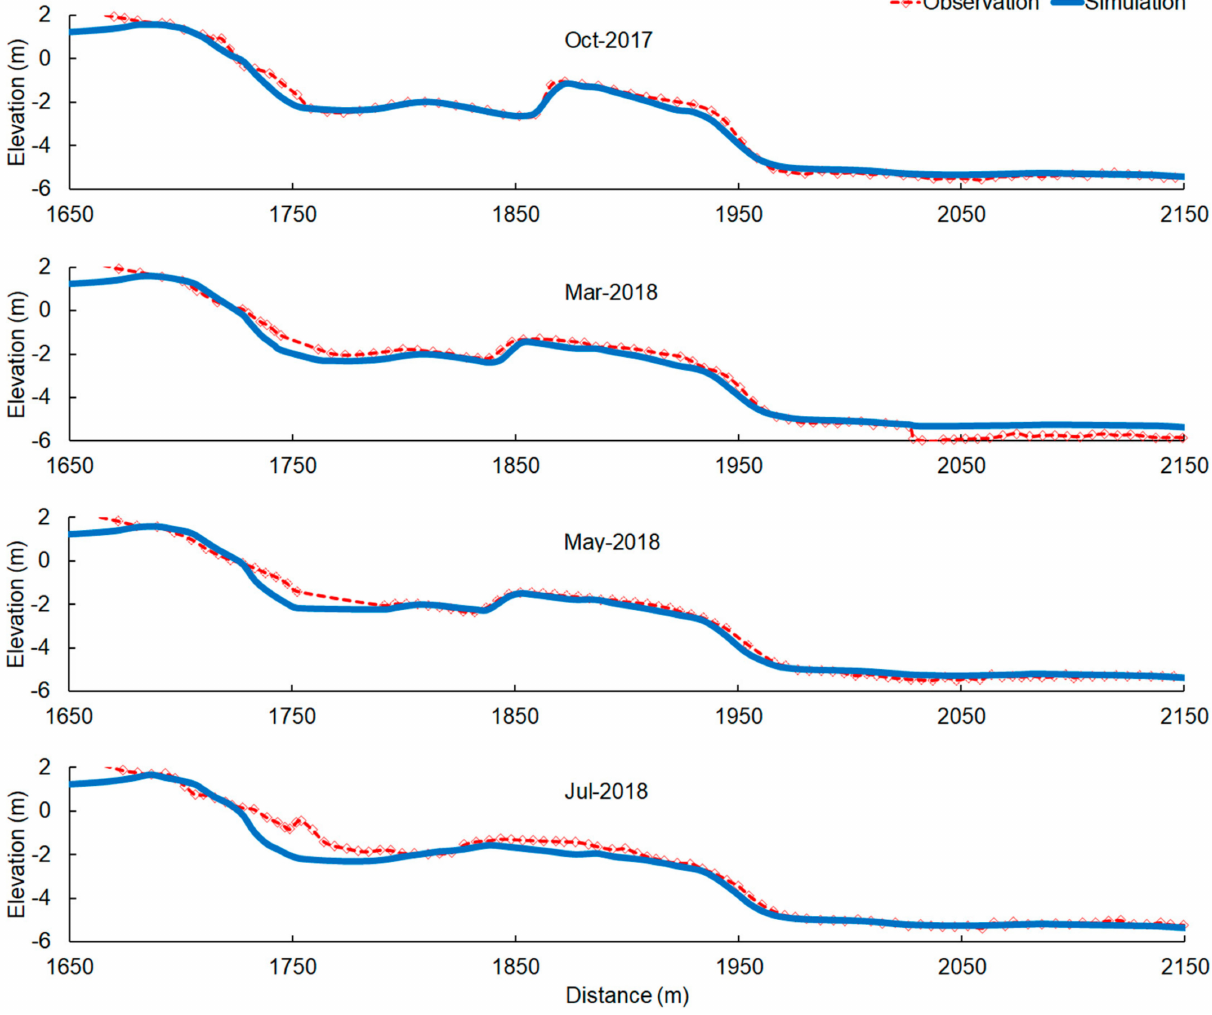
Figure 5. Simulated and observed beach profiles at P8 cross-section from October 2017 to July